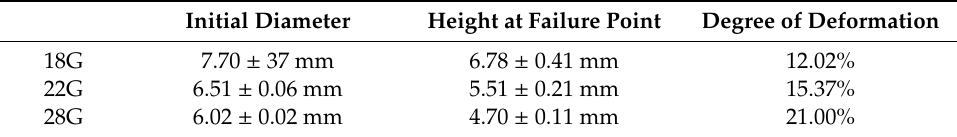
Table 2. Initial diameter and degree of deformation of cylinders printed by di ff erent nozzles (n =